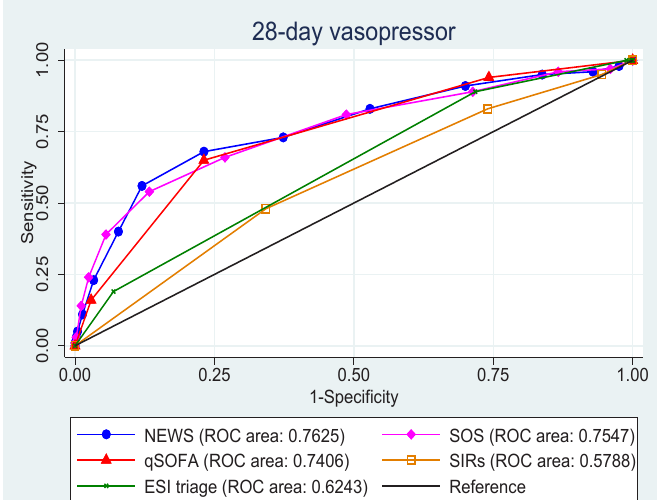
Figure 4. The AUROC of the predictive scores for predicting 28- day vasopressor